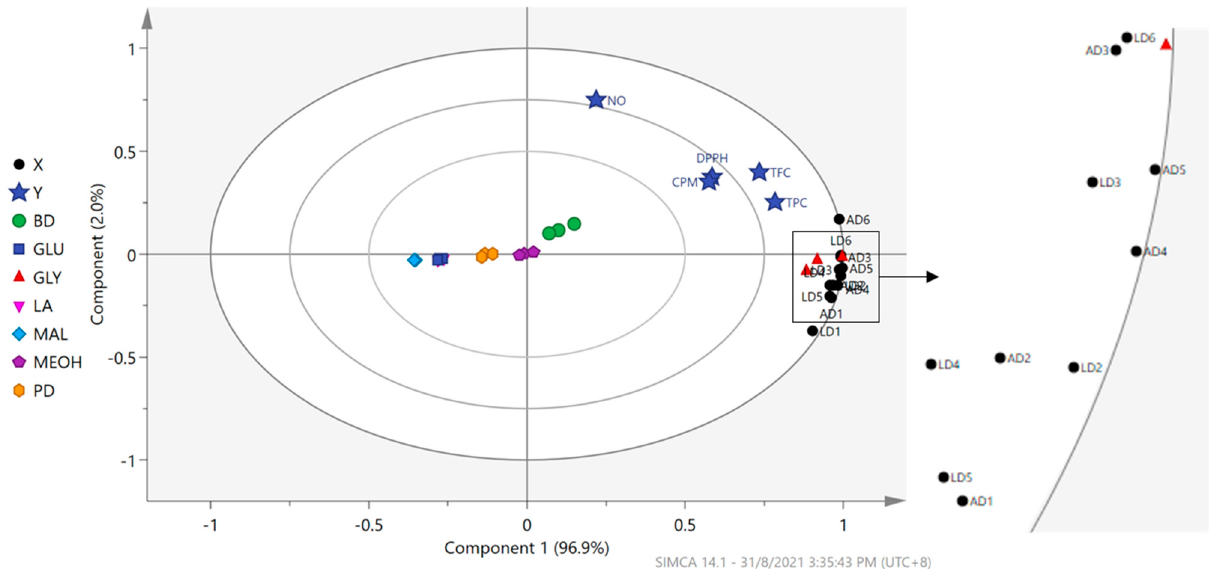
Figure 6. Biplot of the partial least square (PLS) model exhibiting correlation between relatively quantified luteolin and apigenin derivatives and wound healing activity of OPL extracts obtained from various green solvents. Abbreviations: BD, choline chloride–1,4 butanediol; GLU, choline chloride–glucose; GLY, choline chloride–glycerol; LA, choline chloride–lactic acid; MAL, choline chloride–maltose; MEOH, aqueous methanol; PD, choline chloride–1,2 propanediol; TPC, total phenolic content; TFC, total flavonoid content; DPPH, 2,2-diphenyl-1-picrylhydrazyl; NO, nitric oxide; CPM, cell proliferation and migration; LD, luteolin derivatives; AD, apigenin derivatives; LD1, luteolin-6,8-di-C-hexose (Isomer 1); LD2, luteolin-6,8-di-C-hexose (Isomer 2); LD3, isoorientin; LD4, orientin; LD5, luteolin-6-C-hexose-8-C-deoxyhexose (Isomer 1); LD6, luteolin-6-C-hexose-8-C-deoxyhexose (Isomer 2); AD1, apigenin-6,8-di-C-hexose; AD2, apigenin-6-C-pentose-8-C-hexose (Isomer 1); AD3, apigenin-6-C-pentose-8-C-hexose (Isomer 2); AD4, vitexin; AD5, isovitexin; AD6, apigenin-6-C-hexose-8-C-deoxyhexose.